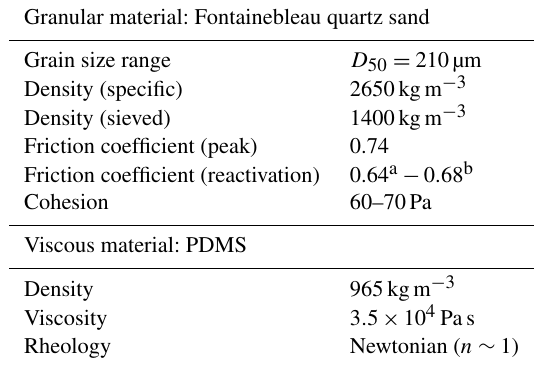
Table 1. Material